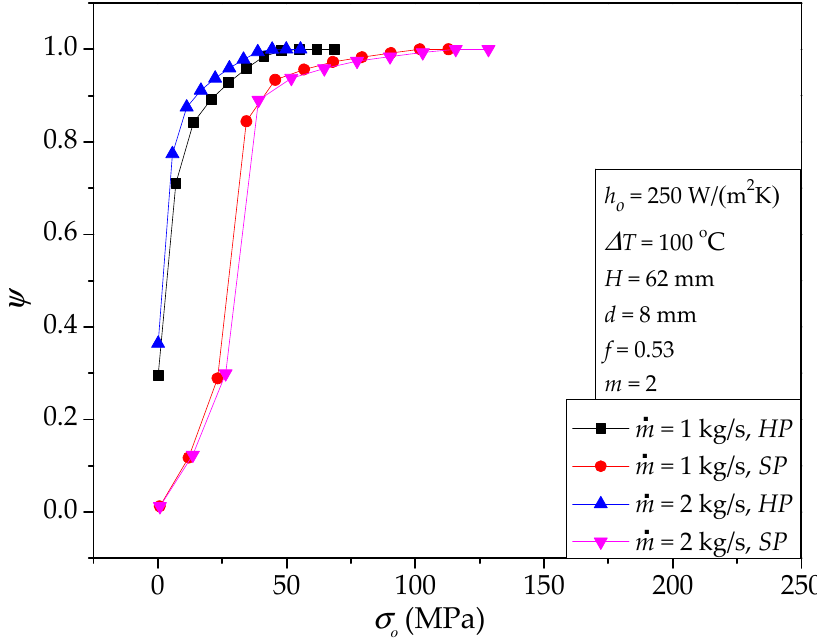
Figure 10. Cumulative von Mises stress distribution for different flow rates: h o = 250 W/(m 2 K), Δ T =